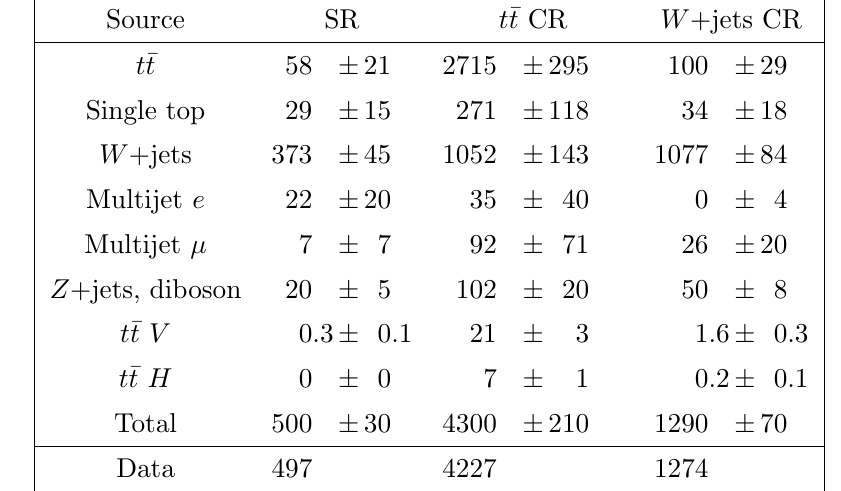
Table 4. Event yields in the SR and the t (cid:22) t and W +jets CRs after the (cid:12)t to the background-only hypothesis. The uncertainties include statistical and systematic uncertainties. Due to correlations among the SM backgrounds and the corresponding nuisance parameters, the uncertainties in the individual background components can be larger than the uncertainty in the sum of the background, which is strongly constrained by the